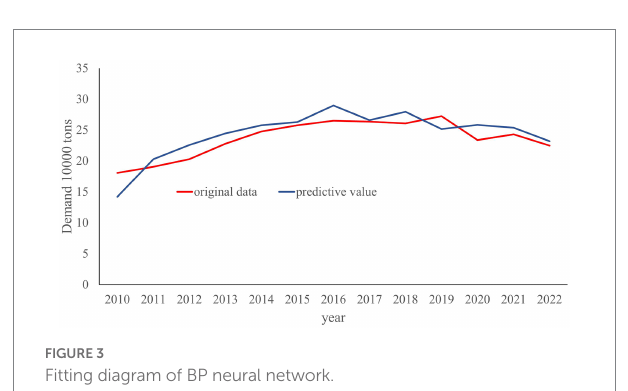
FIGURE 3 Fitting diagram of BP neural